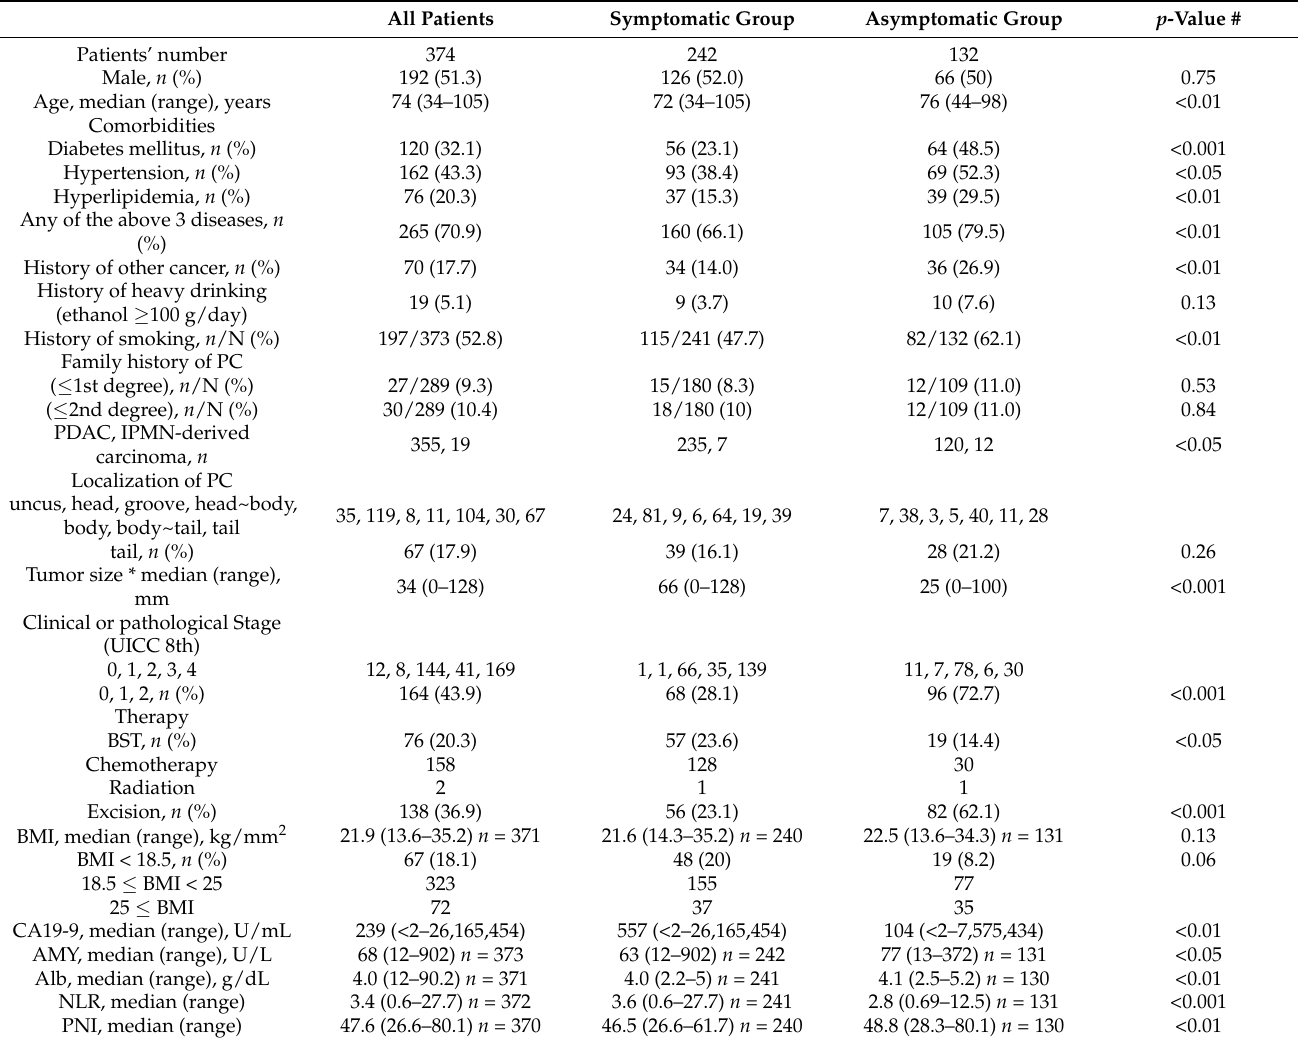
Table 1. Patients’ characteristics in all